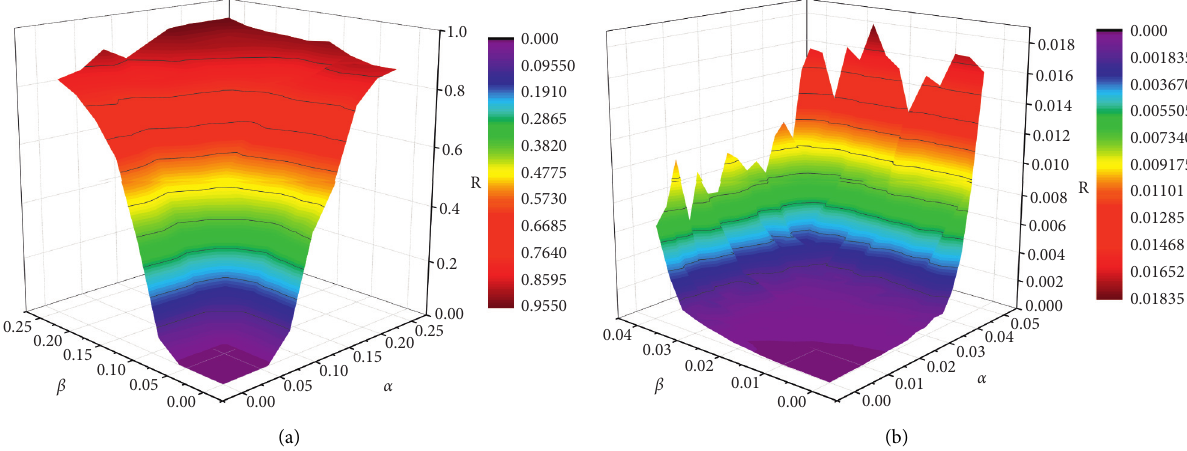
Figure 3: Density of stifler over time for different values of α and β at steady state. (a) WS small-world network. (b) BA scale-free network.